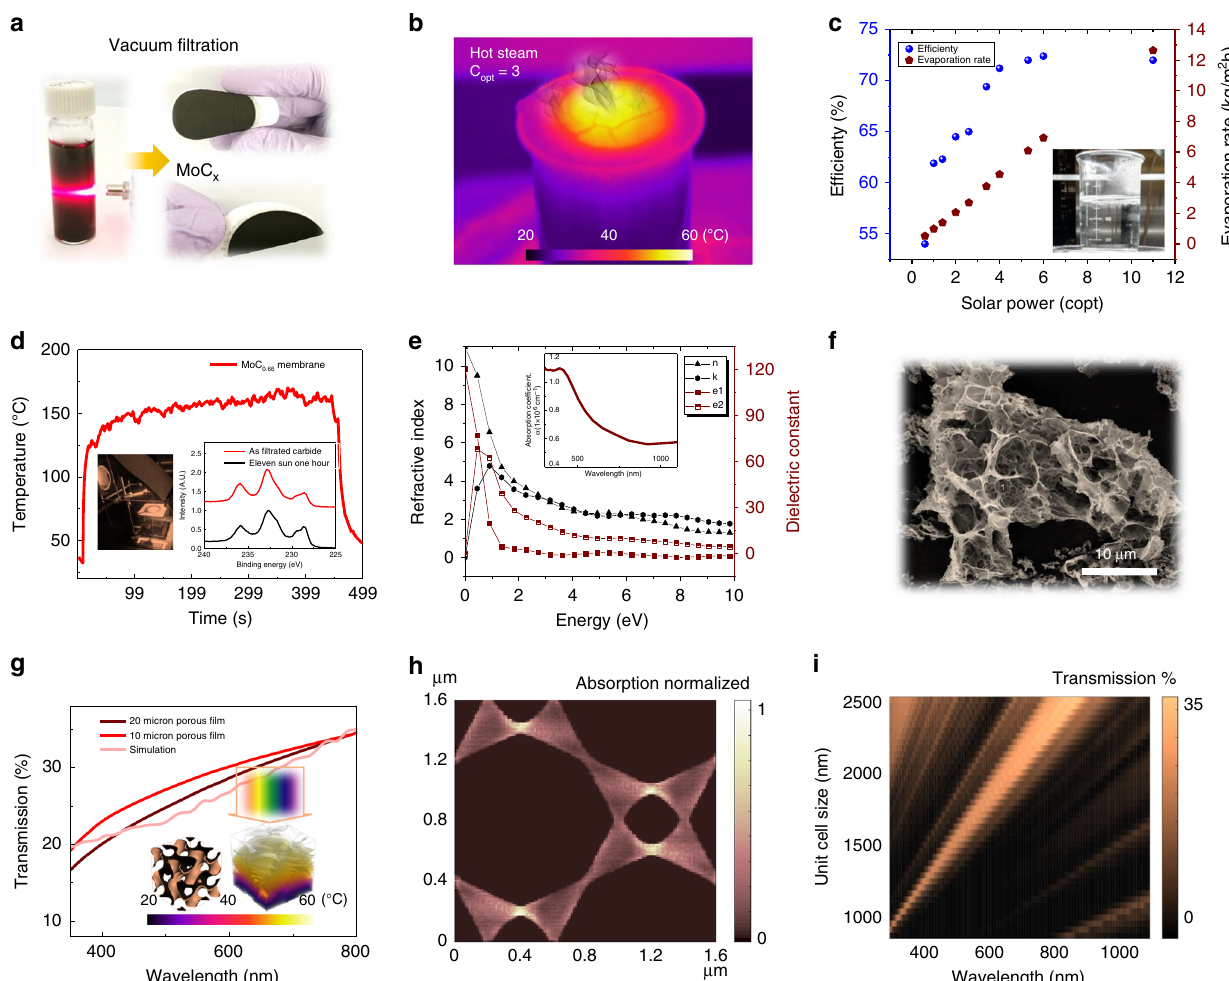
Fig. 3 Laser-sculptured carbide for solar-steam generation membrane. a Fabrication schematic of carbide membrane. Laser-induced carbide is dispersed in DI water, which is condensed to a fl exible membrane by vacuum fi ltration. b Solar-steam generation using carbide membrane to harvest solar-thermal energy. c Evaporation rate and energy ef fi ciency of carbide membrane under different incident solar power. d Temperature fi le of MoC 1-x under extreme solar irradiation (11 sun, inset). XPS of MoC 1-x Mo_3d orbital before and after 11 sun exposure for 1 h. e Simulated refractive index, dielectric constant, and absorption coef fi cient of MoC 1-x by density functional theory. f SEM of laser structured porous MoC x with connected curved surface. g Transmission spectrum of 10 μ m and 20 μ m porous carbide thin fi lms. Inset: simulated transmission curve of approximate carbide structure (inset) and simulated temperature pro fi le in carbide unit cell. Incident light power C opt = 3 (3 kW m − 2 ). h Simulated absorption of 500 nm incident light within a unit cell (1.6 μ m) to illustrate the energy localization within the porous carbide structure. i Transmission intensity of different wavelengths in different